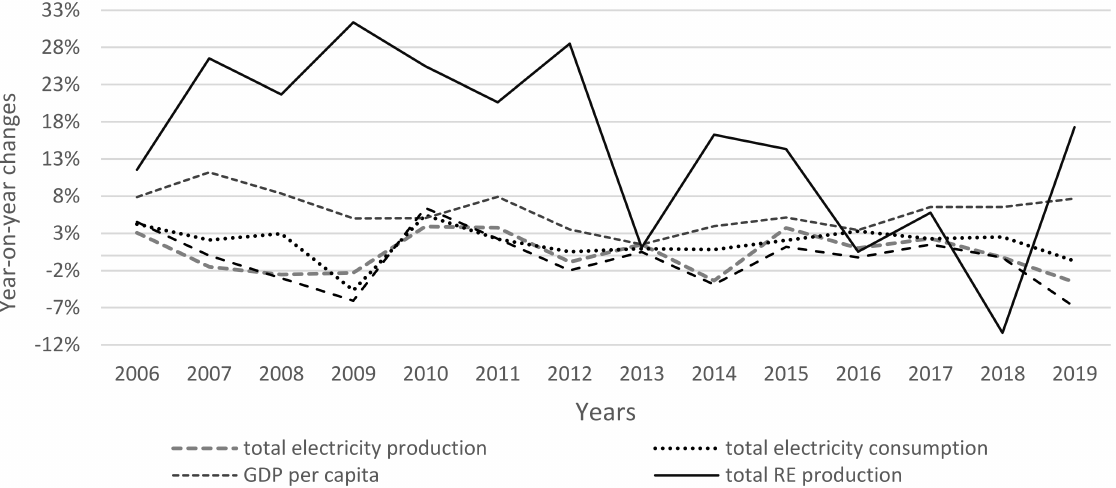
Figure 1. Dynamics of total electricity production and consumption, GDP per capita, renewable energy production, and the level of CO 2 emission (carbon dioxide) in Poland in 2006–2019. Source: own elaboration based on